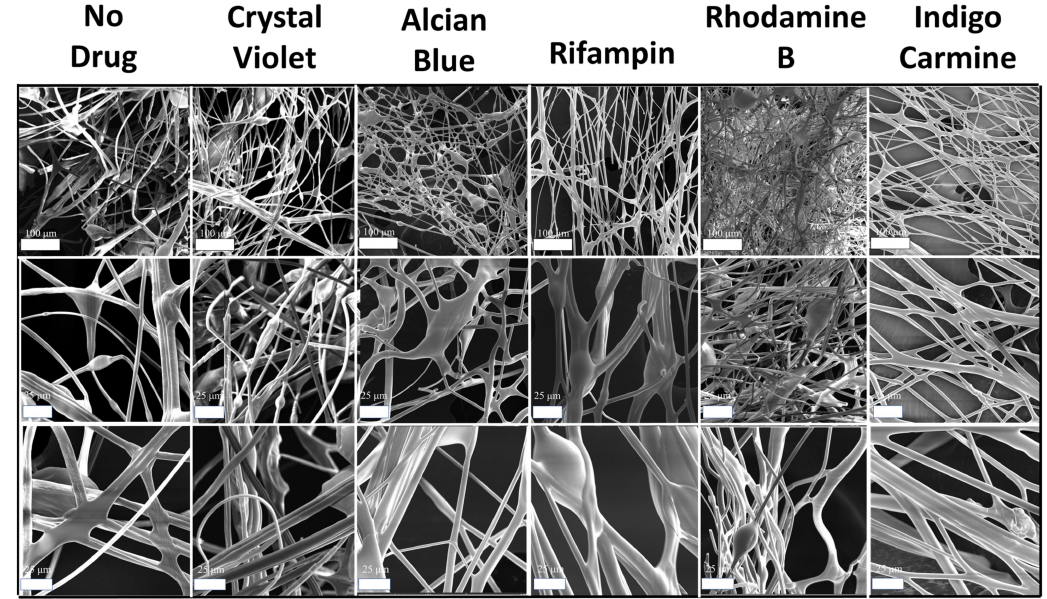
Figure 7. SEM images of silk-model drug air-spun fibers. First row scale bars are 100 µ m. Second and third row scale bars are 25 µ m.